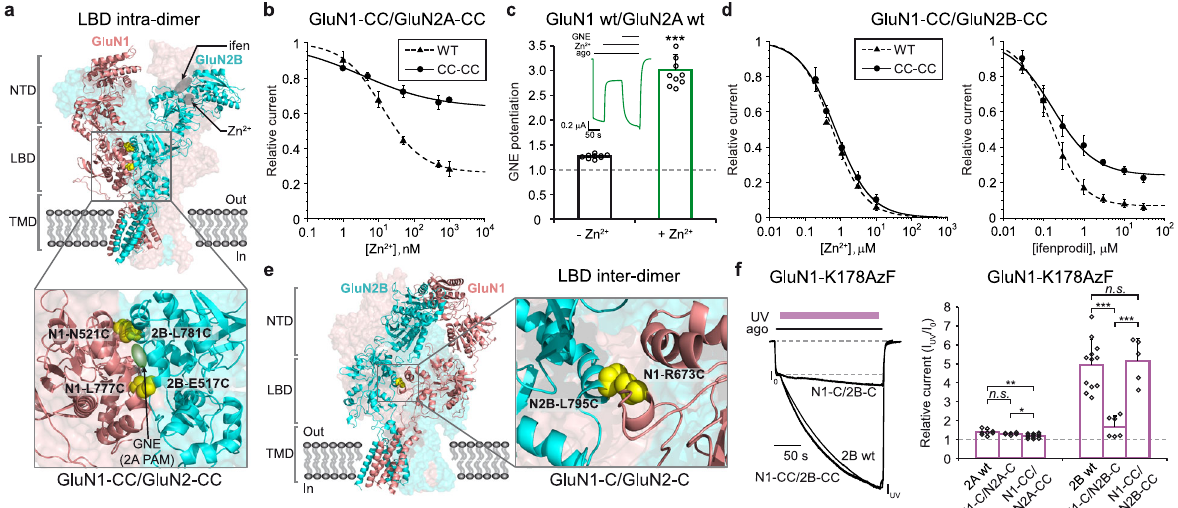
Fig. 5 Inter-layer NTD-LBD coupling differs between GluN2A and GluN2B receptors. a Structure of the full-length GluN1/GluN2B receptors